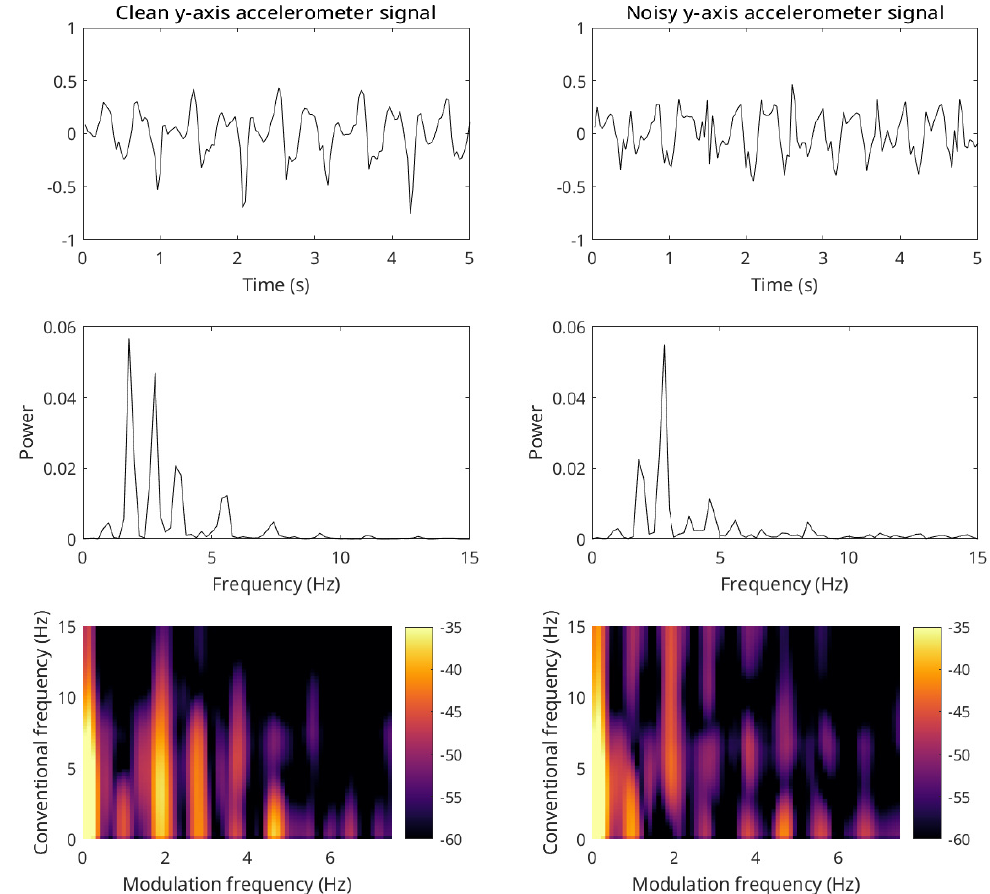
Figure 7. Time domain representation ( top plots ) of a clean ( left ) and noisy ( right ) y -axis accelerome- ter signal segment (sampled at 30 Hz) and their corresponding spectra ( middle plots ) and modulation spectrograms ( bottom plots